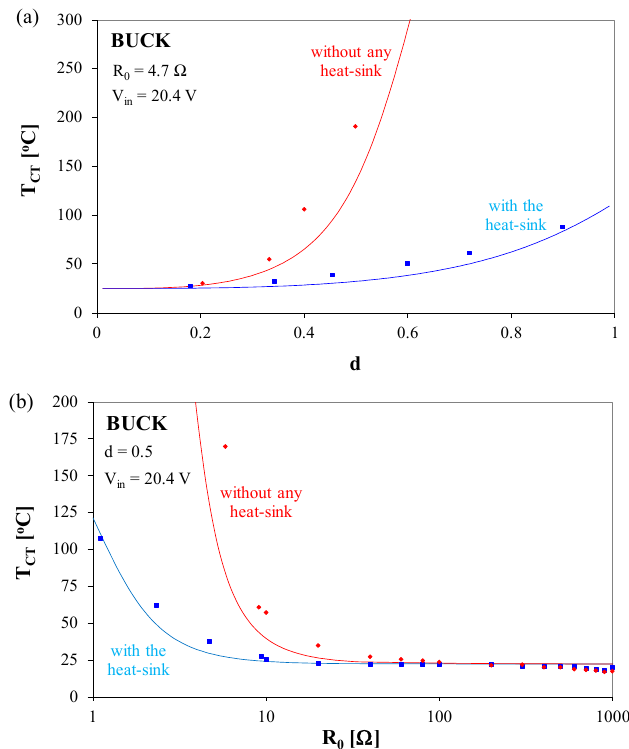
Figure 7. Dependences of the case temperature of the transistor contained in the buck converter on: ( a ) the duty cycle d, ( b ) on load resistance.